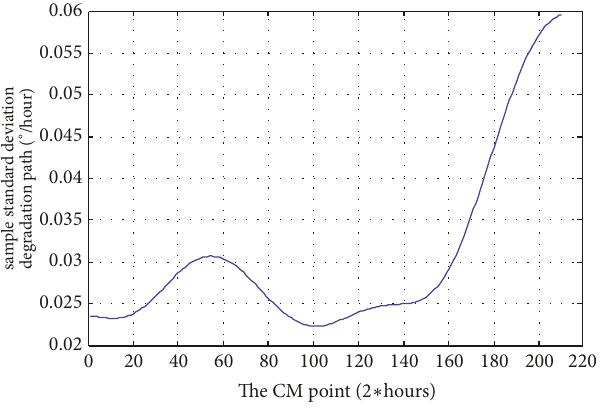
Figure 8: Simulation based on the parameter